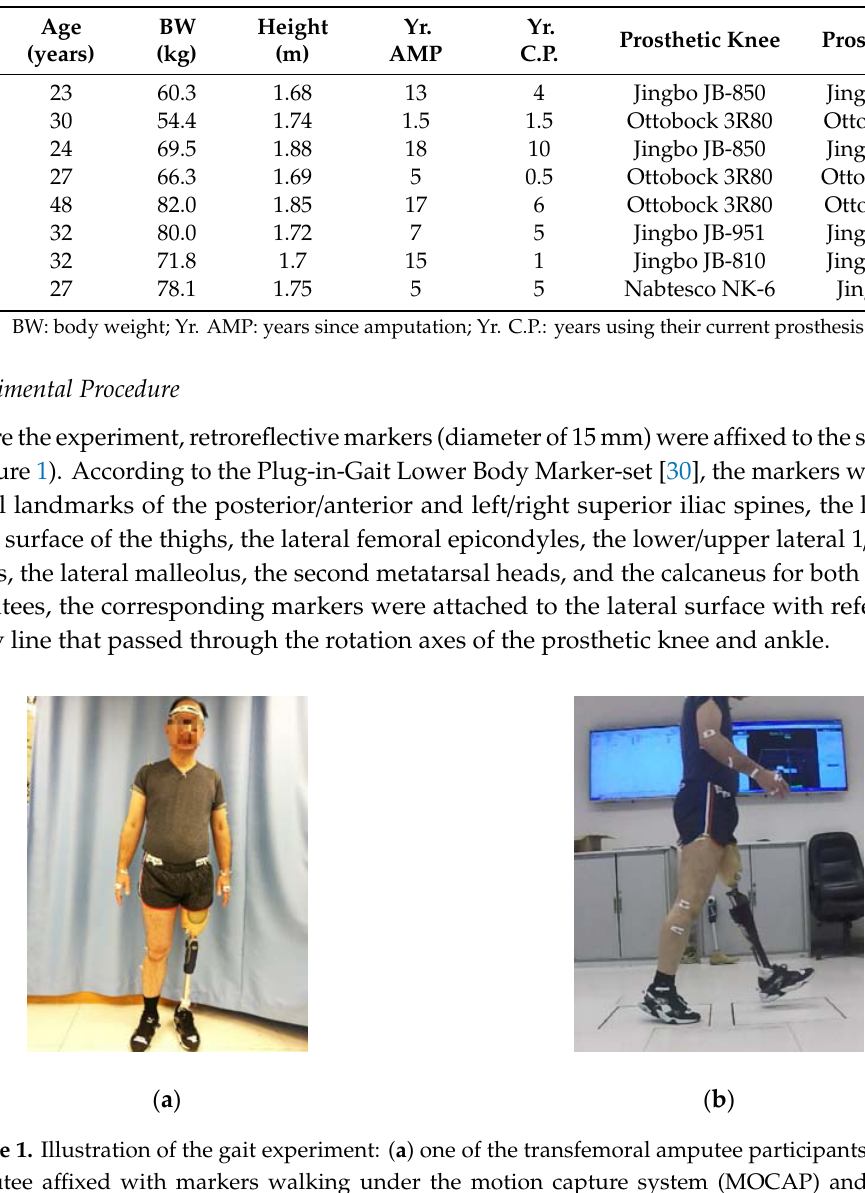
Table 1. Participant information for the amputee group.